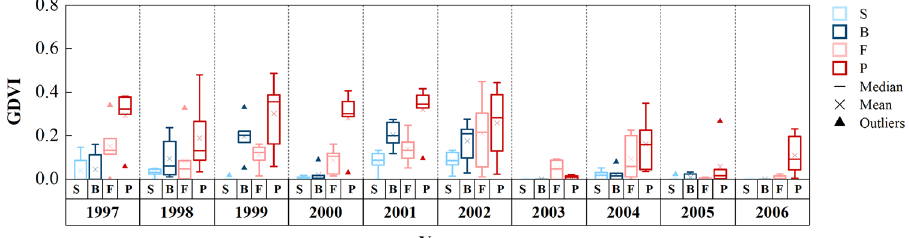
Fig. 7 Growth-stage-based drought vulnerability index (GDVI) of soybean from 1997 to 2006 in the Huaibei Plain study area in Anhui Province, China. Note: S = Seedling stage; B = Branching stage; F = Flowering & pod-setting stage; P = Pod-filling